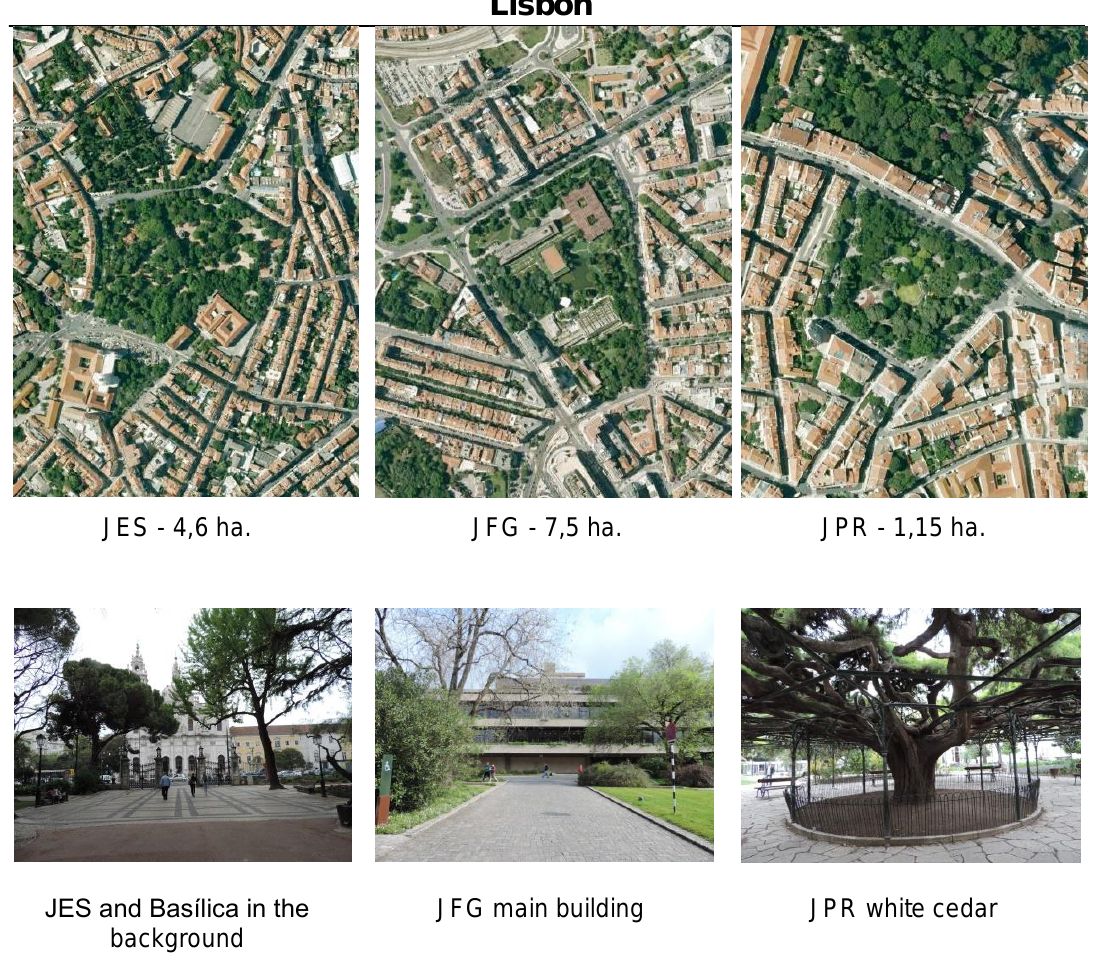
Figure 3: Urban parks in